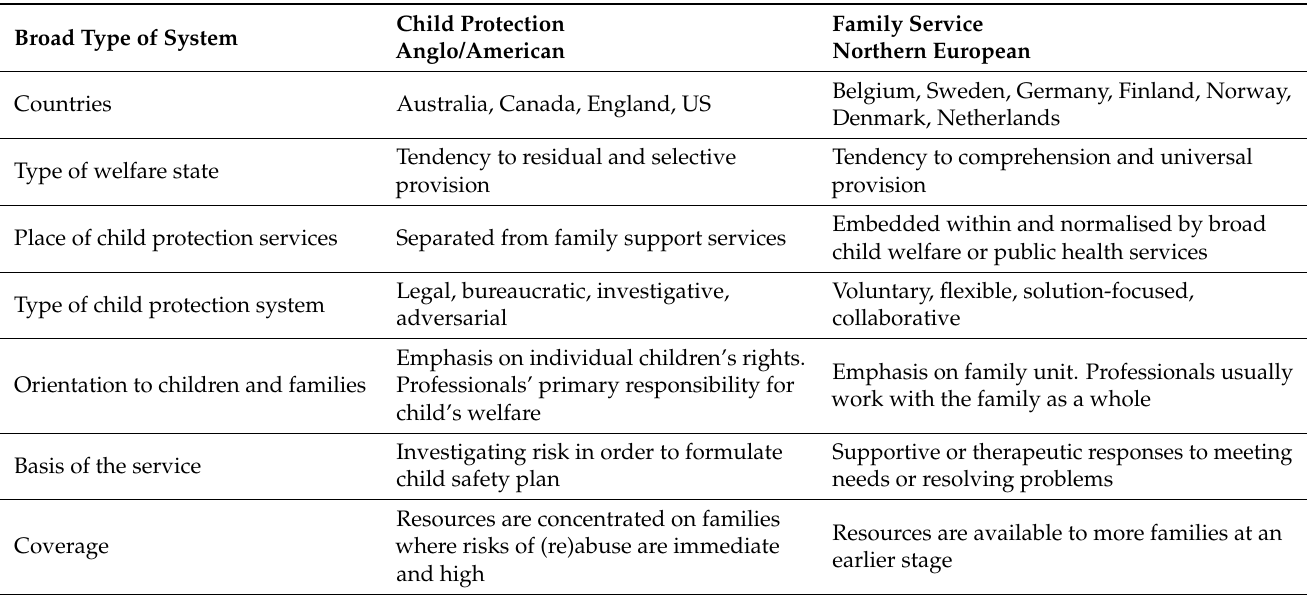
Table 1. Difference between Child Protection (Anglo/American) and Family Service (Northern European)